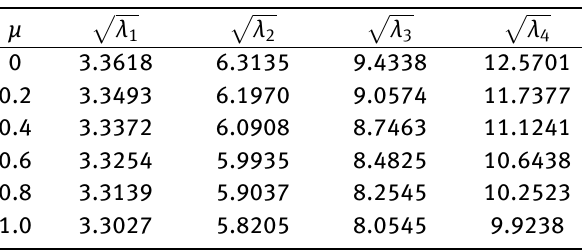
(︁ √ )︁ for CC case for different non- λ